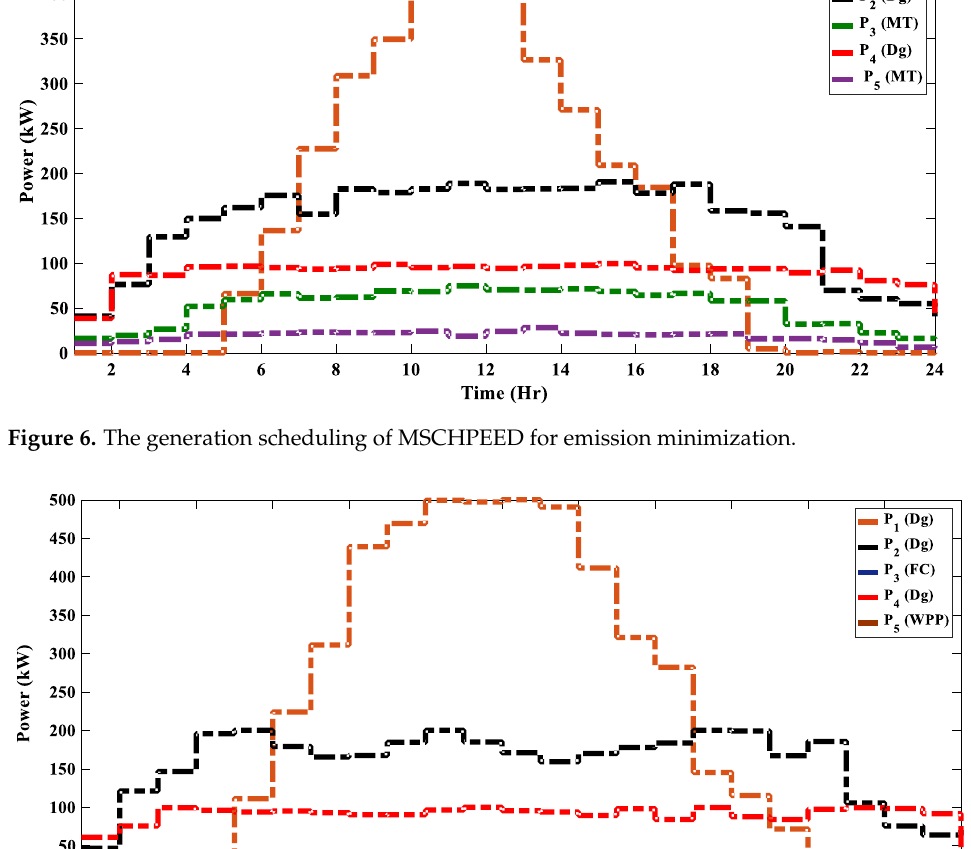
14 of 20 Figure 4. The generation scheduling of MSCHPEED for cost minimization. Figure 5. The generation scheduling of MSCHPEED with REI for cost minimization. 4.2.2. Best Emission Solution